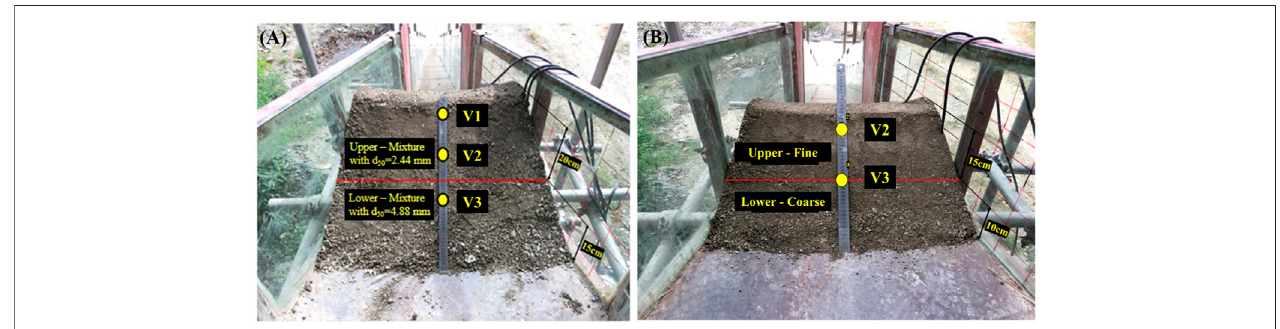
FIGURE3| Piezometersensorspositionedinequalspacinglocationsalongtheverticalcenterlineofhigh(left)andlow(right)arti fi cialdambeforetest.Note:allthree sensors are used for high-elevation dam (A) and two sensors are employed for low-elevation dam (B)